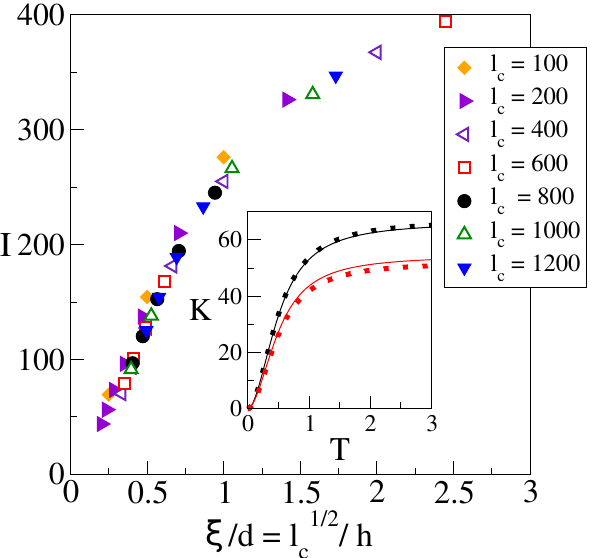
Figure 6. Integral I , given by Equation (26) of the thermal conductance over frequency for wires with different combinations of the disorder parameters. Overlapping region confirms the universality (25). The size of the wire is d × L = 256 × 2048. Data for the same symbol correspond to samples with different surface corrugation h . Inset confirms that two samples with the same value of ξ possess the same thermal conductance K ( T ) for any temperature (shown by solid lines and dots, respectively)